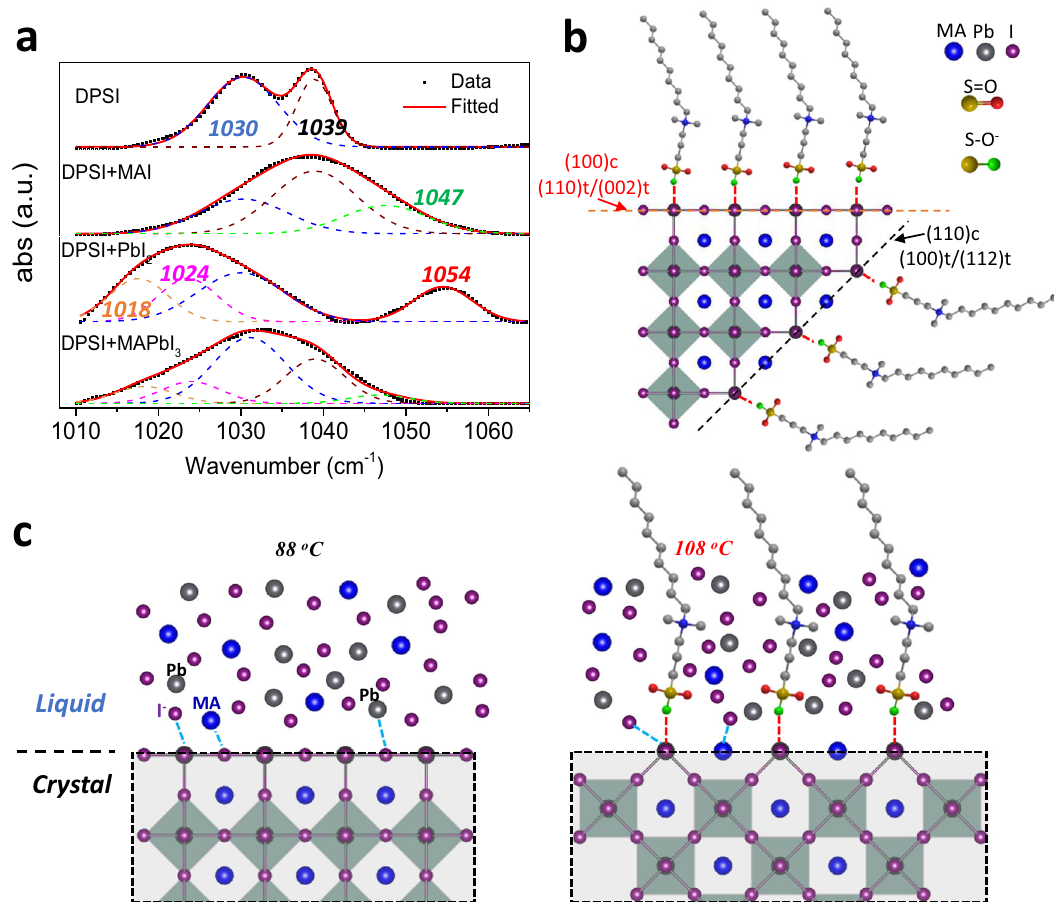
Fig. 2 Mechanism of crystal growth with DPSI. a FTIR spectra of the powders of MAI, PbI 2 , and MAPbI 3 with 10 mol% DPSI. b Scheme of DPSI absorption difference on different crystal facets which have different Pb 2 + density. c Scheme of crystal growth mechanism at the surface of crystal where the DPSI molecules modulate the diffusion of metal ions to reach the perovskite surface.